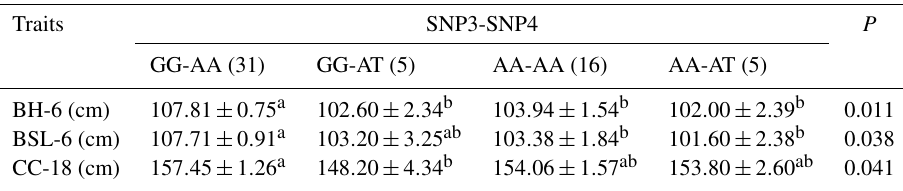
Table 7. Relationship between the combined genotypes of two loci and phenotypes in Nanyang cattle. The numbers in the “traits” column indicate age in months.